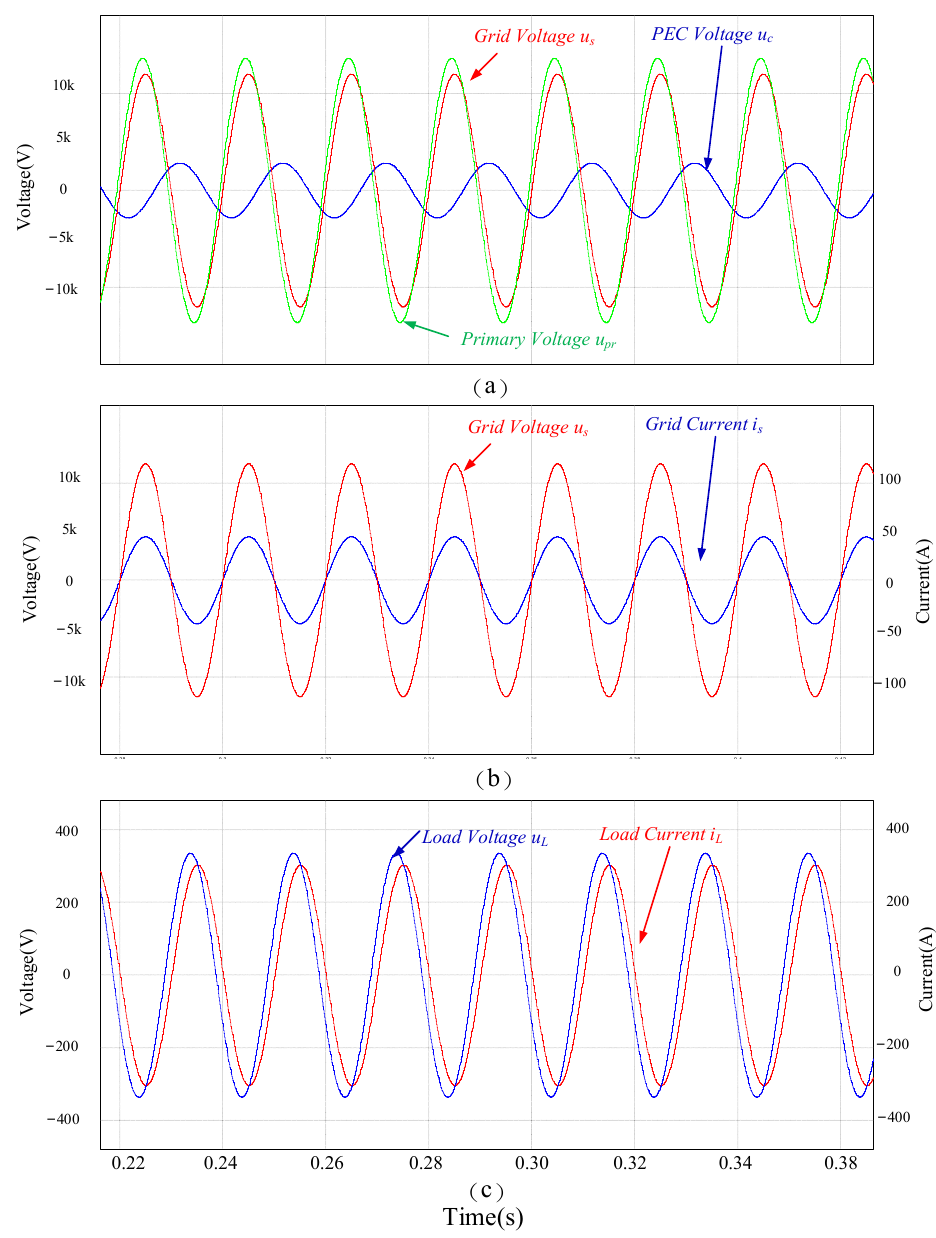
Figure 15. Simulation waveform diagram of complex control with Flexible OLVR.